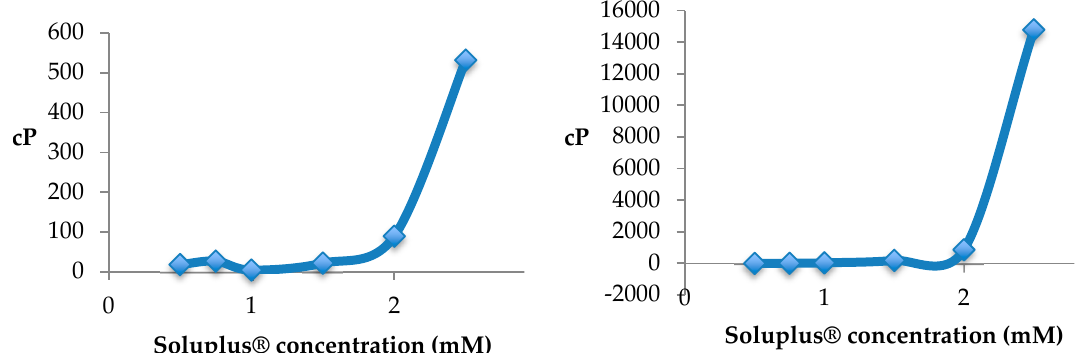
Figure 22. Viscosity of nanomicelle suspensions as a function of Soluplus ® concentration at 25 °C (left) and 35 °C (right).